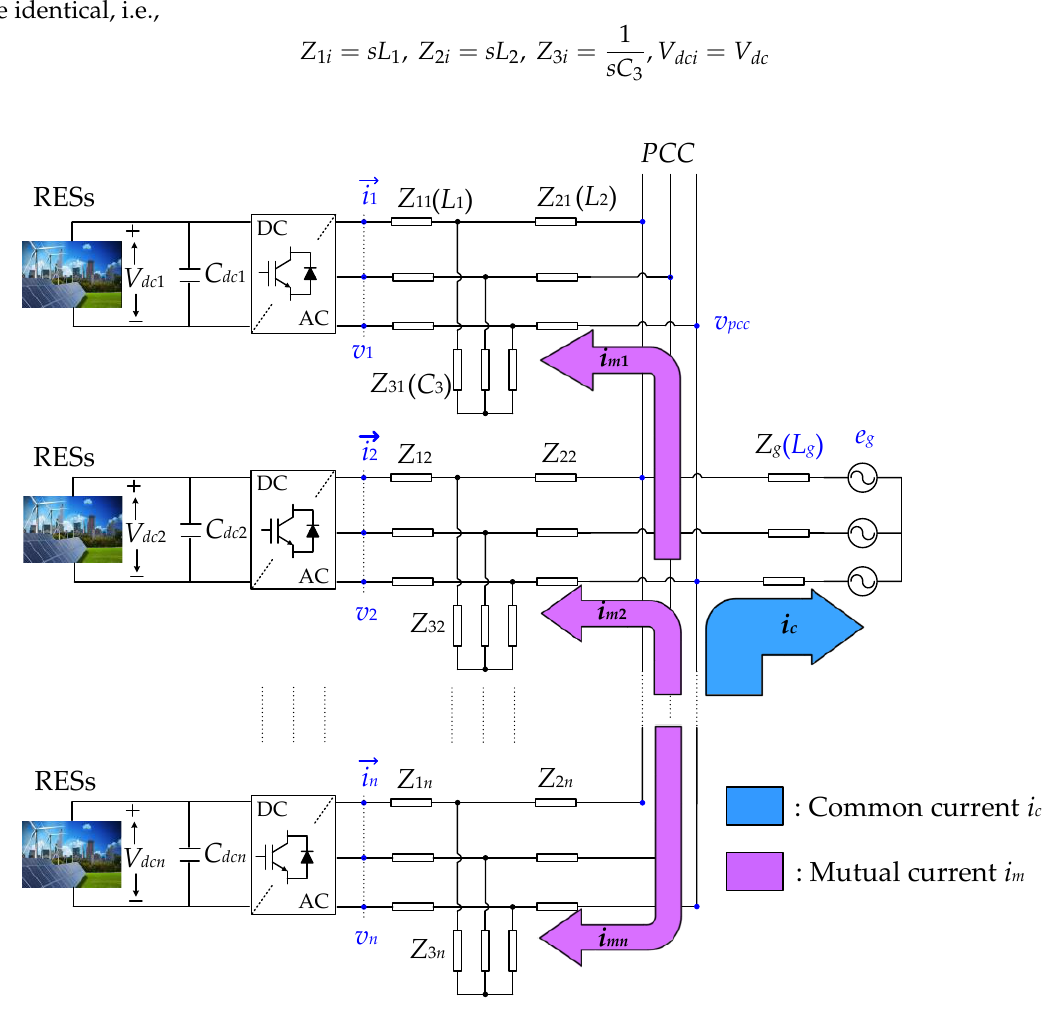
Figure 1. Renewable energy sources (RESs)-based LCL filter-type multi-parallel three-phase grid-connected inverters (GCIs).